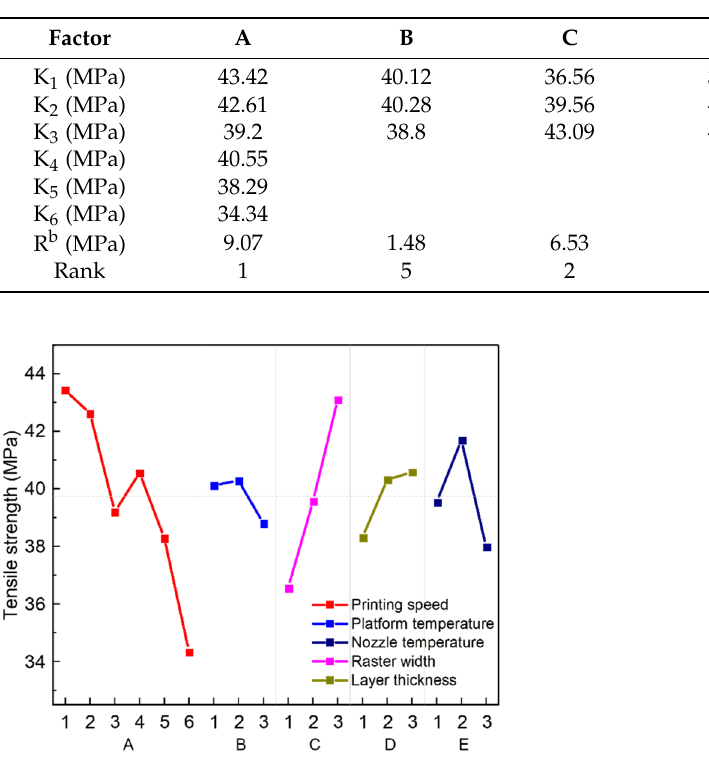
Table 7. Range analysis of the orthogonal experiment (tensile strength).